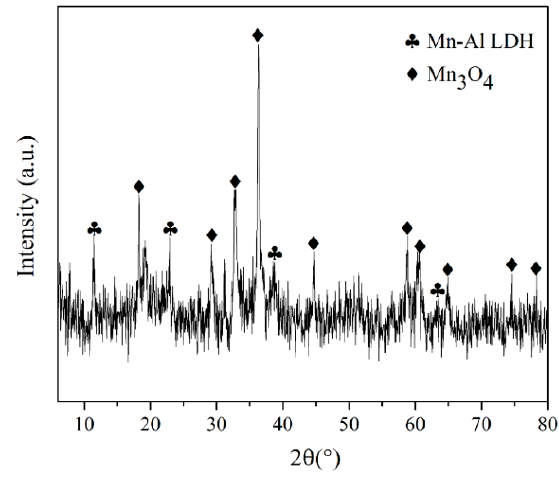
Figure 2. XRD patterns of Mn-Al LDH fillers.